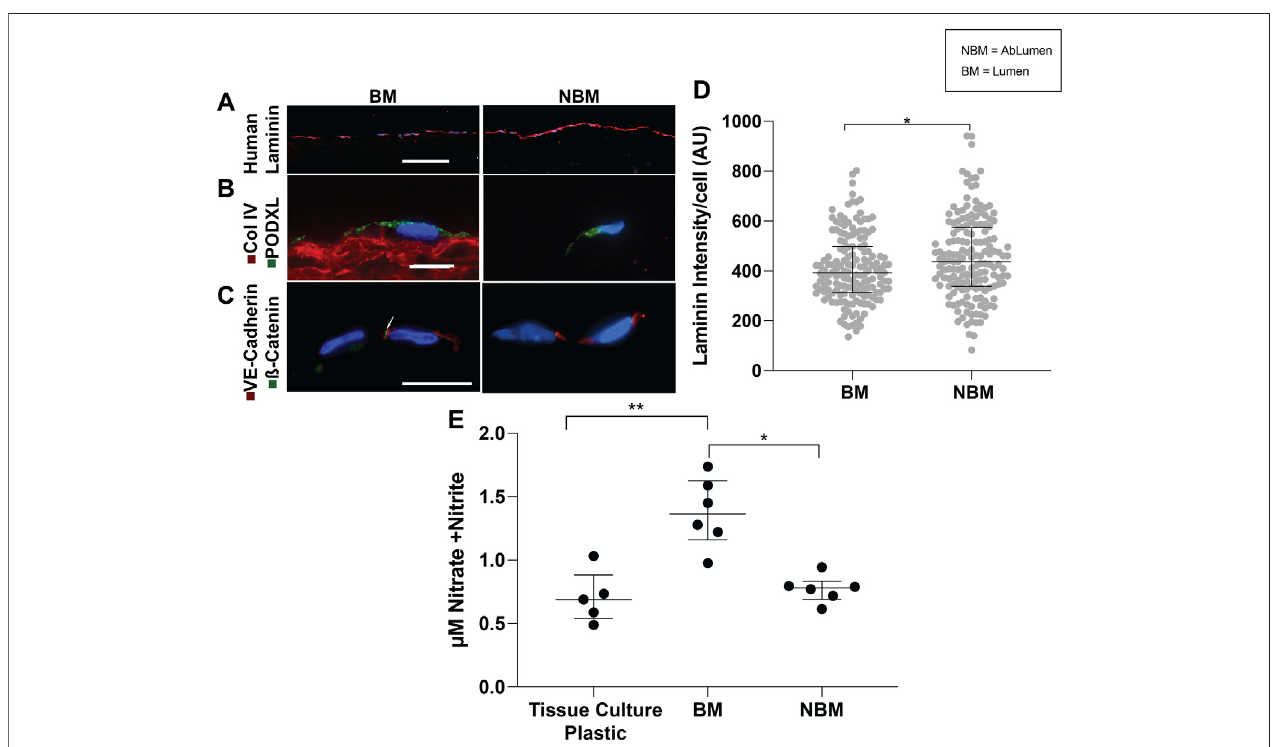
FIGURE 3 | Effects of the presence (BM) versus the absence (NBM) of basement membrane proteins on hAEC phenotypes and functions. Representative images of immuno fl uorescent staining of human laminin production demonstrates the increased production of human laminin in the hAECs seeded on the non-basement membrane protein (NBM) surface when compared to cells seeded on the BM surface (A) . A quantitative analysis of the human laminin production per cell shows a signi fi cant higher production of human laminin by the hAECs seeded on the NBM surface versus on the BM surface (D) . Representative images of immuno fl uorescentstainingforendothelialcellpolarizationdemonstratesthattheBMpresencemediatesthepolarizationofpodocalyxin(green)totheapicalcellsurface ofseededhAECs,indicatingtheir quiescent phenotype (B) . Conversely, apical polarizationofpodocalyxin isnot present on hAECsseededon theNBMprotein side (B) . Similarly,representativeimagesoftheadherencejunctionimmuno fl uorescentstainingforVE-cadherin(red)and β -catenin(green)resultedinappropriateexpressionand co-localizationoftheseadherencejunctionproteins(indicatedbythearrow)inhAECsseededontheBMsurface,whileexpressionandco-localizationisnotseenincells seeded on the NBM protein surface (C) . A quantitative analysis of nitrate and nitrite secretions (nitric oxide biproducts) of HUVEC-seeded AR-scaffolds, show a signi fi cantincrease innitrateand nitritesecretions bycellsseededontheBM protein surface,comparedtothecellsseededontheNBM protein surfaceortissueculture plastic (E) . Scale bar A, 100 µm. Scale bars B and C, 10 µm * = p < 0.05, ** = p <